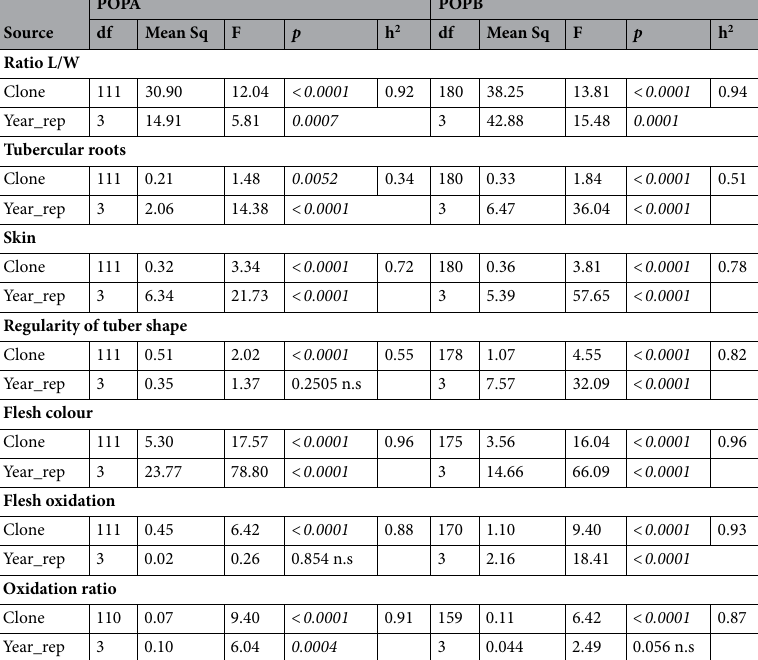
Table 2. Analysis of variance of ratio length/width, tubercular roots, skin texture, shape regularity, flesh colour, flesh oxidation and oxidation ratio. Significant values are in [italics].